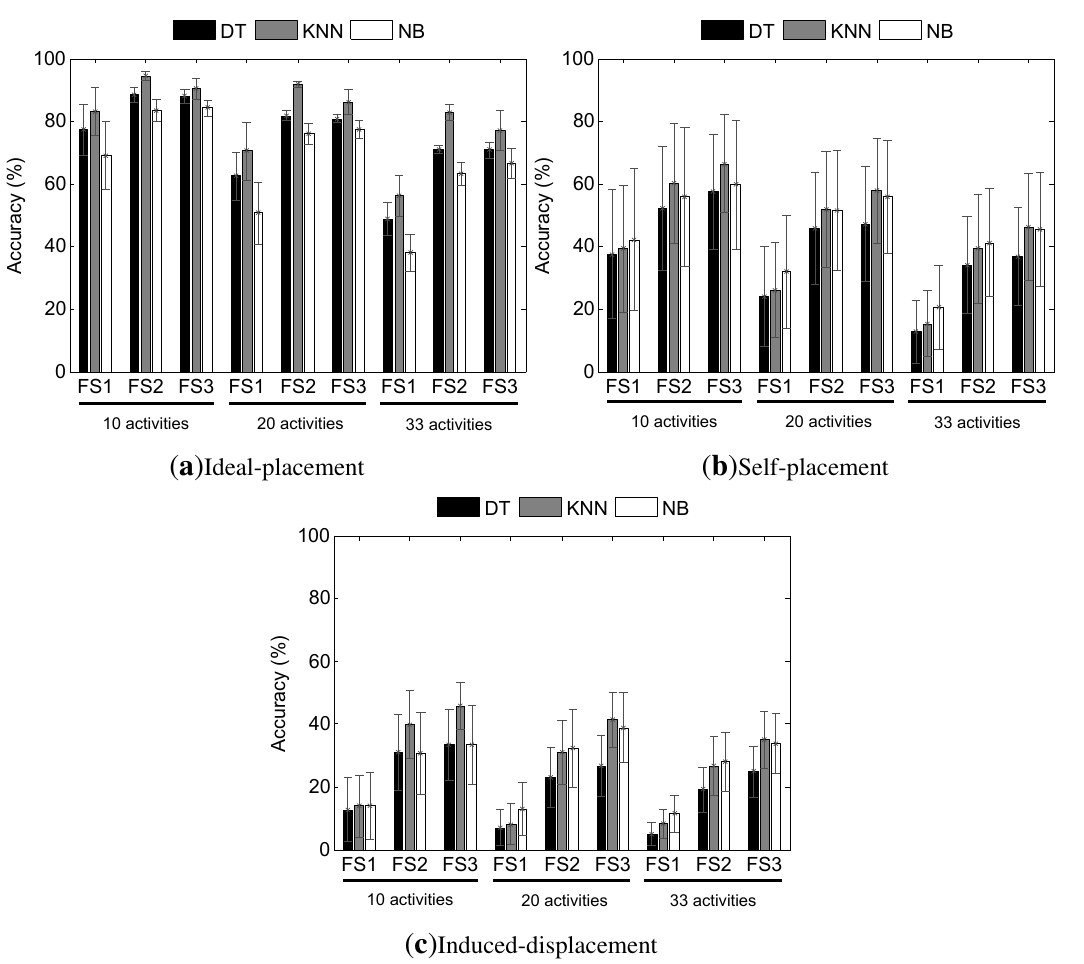
Figure 6. The accuracy (average bar and standard deviation whiskers) results from the evaluation of the single sensor approach across all subjects and sensors for the ( a ) ideal-placement; ( b ) self-placement and ( c ) induced-displacement settings. The top legend identifies the classification paradigm. The horizontal axis labels identify the feature set used for each experiment. The activity recognition dataset ( i.e. , the number of activities) used is respectively